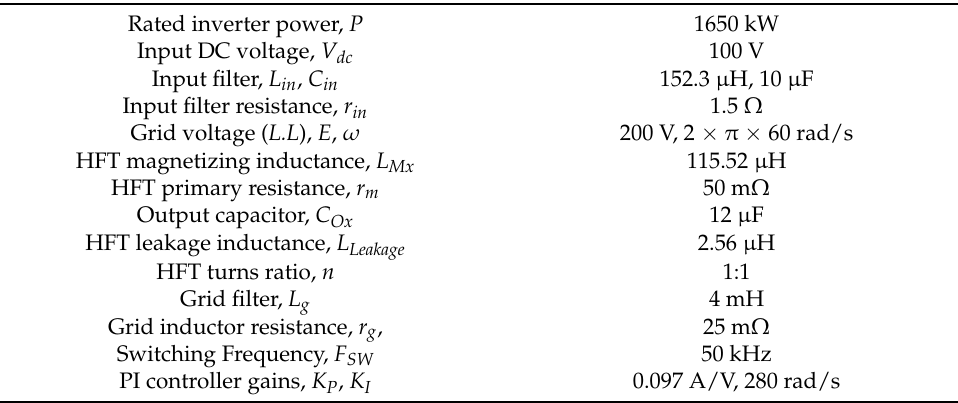
Figure 14. Experimental system prototype photograph. Table 7. Experimental parameters of the